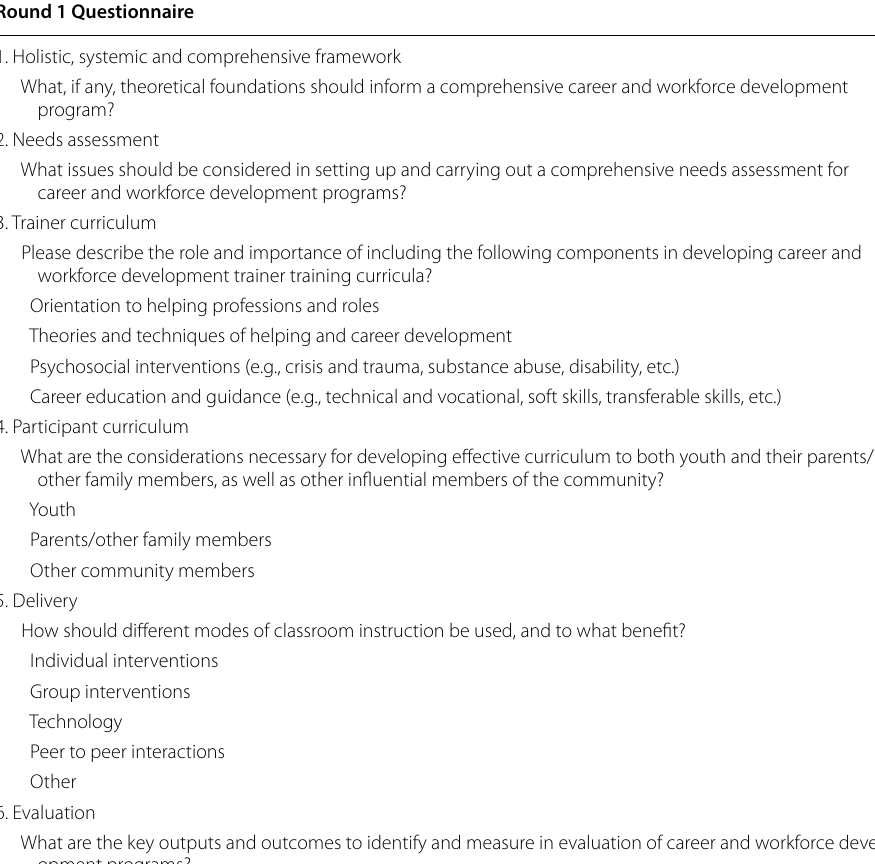
Table 1 Sample questionnaire